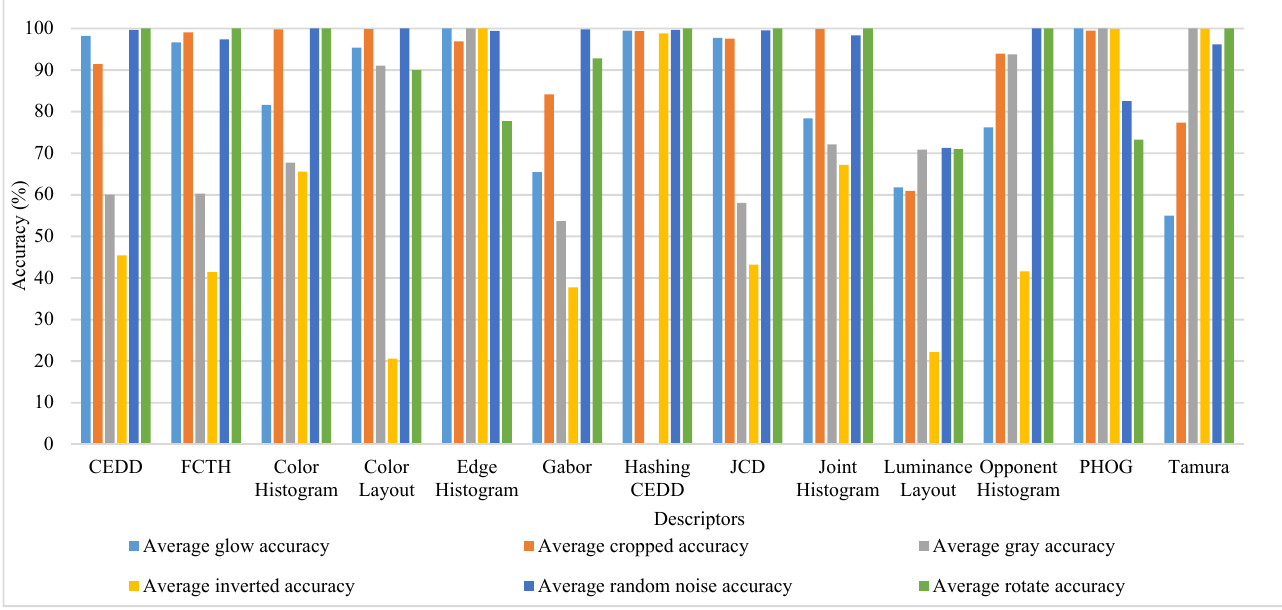
Figure 22. Comparing all descriptors from a viewpoint which relates all of the descriptors to the filters. Here, another way to rank the descriptors according to image retrieving performance using the average precision@K is shown. Out of the number of images, k is set to 10,000. Figure 23 shows the precision@10,000 for all the used descriptors. As can be seen, on av- erage, the PHOG has the best precsion@10,000 followed by Hashing CEDD, where they locate the images early with a relatively high score. Other descriptors vary in their measures based on the image position in the retrieval process. However, it is recom- mended to consider each descriptor separately along with each type of image to be re- trieved.